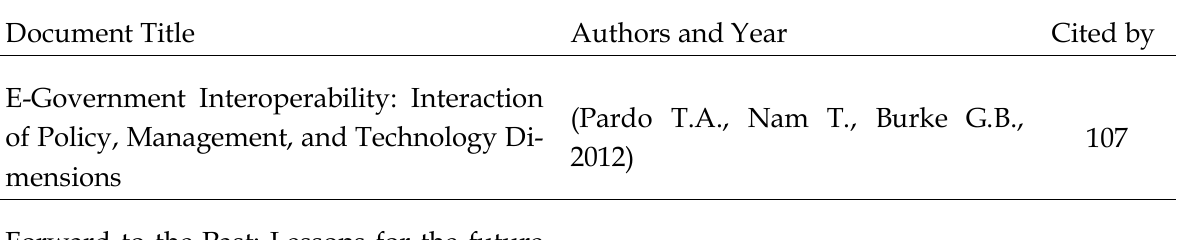
Table 1: Article with Hight Citation. Source: Scopus